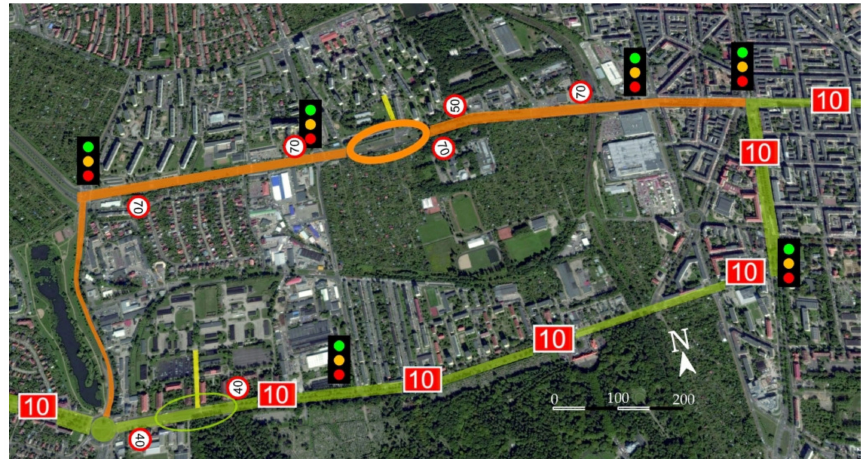
Figure 1. Study area shown on a background of a satellite image of a part of the city of Szczecin, Poland. (Source: own work of the authors using Google Earth satellite imagery